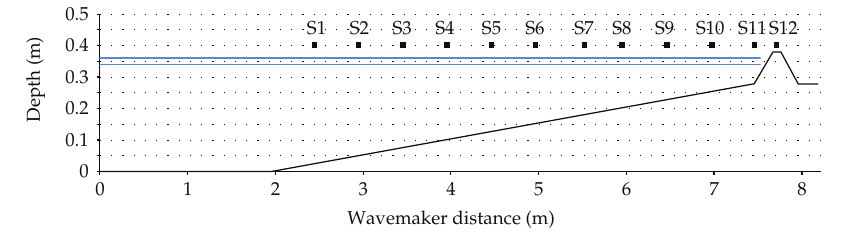
Figure 8: Sketch of the flume for the Stansby and Feng (cid:6) 32 (cid:7)